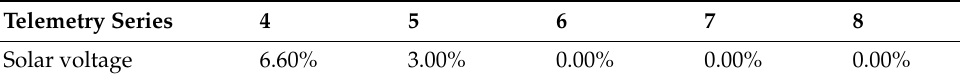
Table 4. The detection of false positive rate (FPR) with sliding window fusion under different support